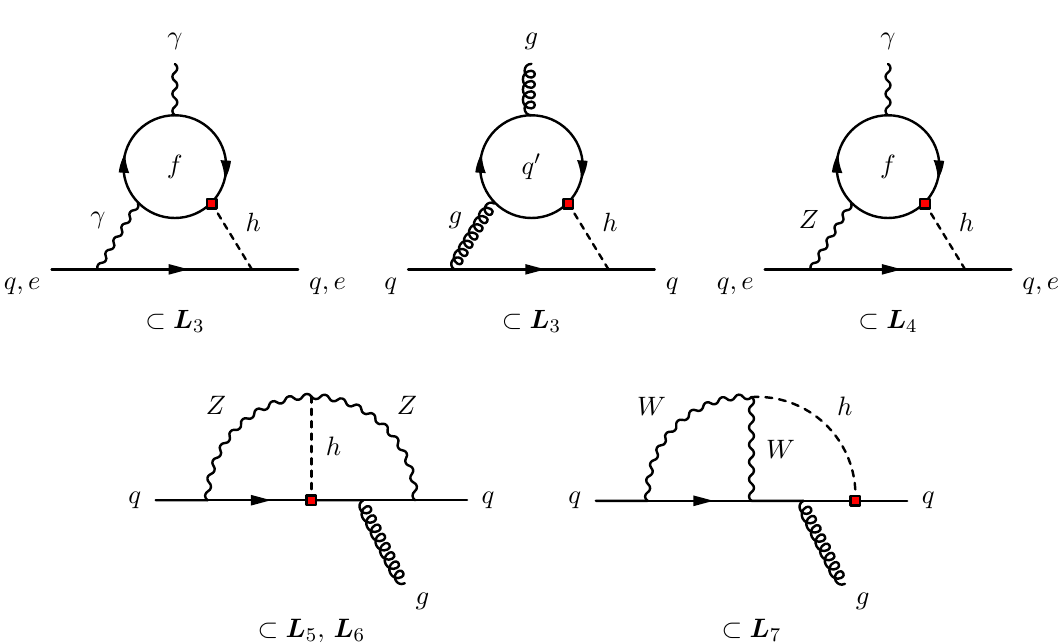
Figure 3 . Representative Barr-Zee-type Feynman diagrams contributing to the two-loop matching of dipole operators at the electroweak scale. The label under the diagrams indicates the loop function ( L 3 – L 7 ) to which the corresponding diagram contributes. The red square vertex indicates a CP-violating Higgs Yukawa, C fH − . Here, f denotes fermions and q 0 quarks. The electroweak contributions to the chromo EDM operator from diagrams like the ones in the second row are UV finite as opposed to the ones in figure 2. See main text for